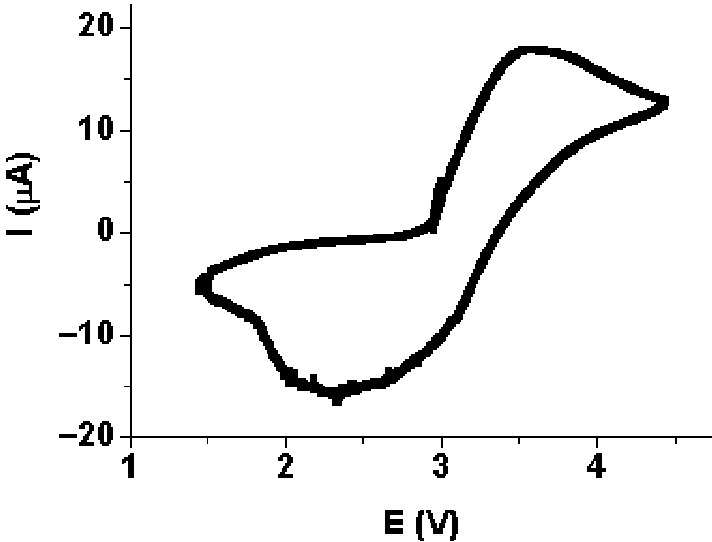
Figure 13. Current–voltage curve (3rd cycle of potential sweep) for Li|Li 3.8 Ge 0.9 S 0.1 O 4 |Li 1.3 V 3 O 8 electrochemical cell at 100 ◦ C.